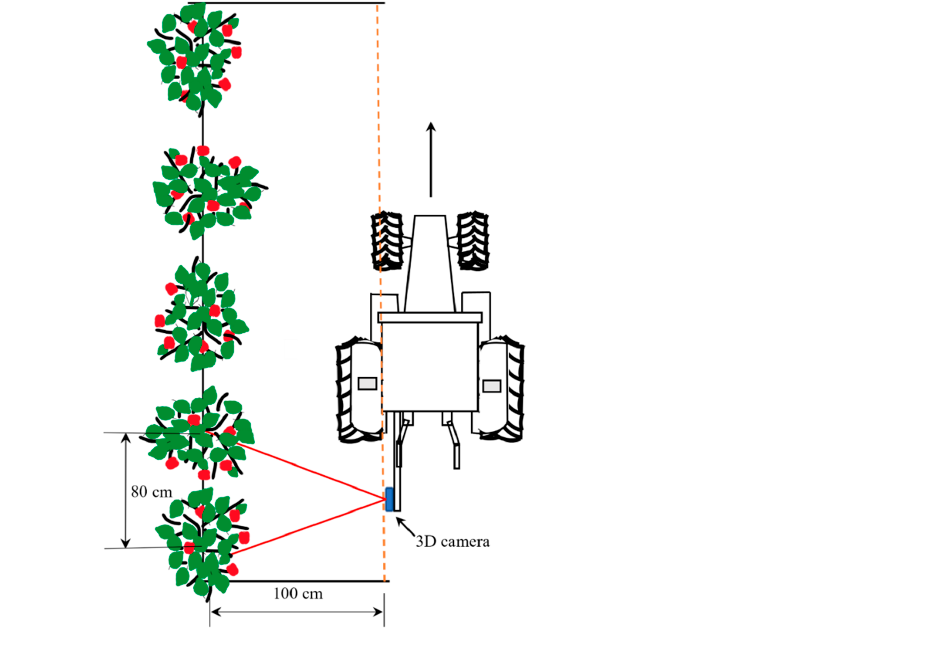
Figure 8. Outdoor data collection procedure at different forward speeds and orientation angles for the recognition of apples and distance information using a 3D camera.